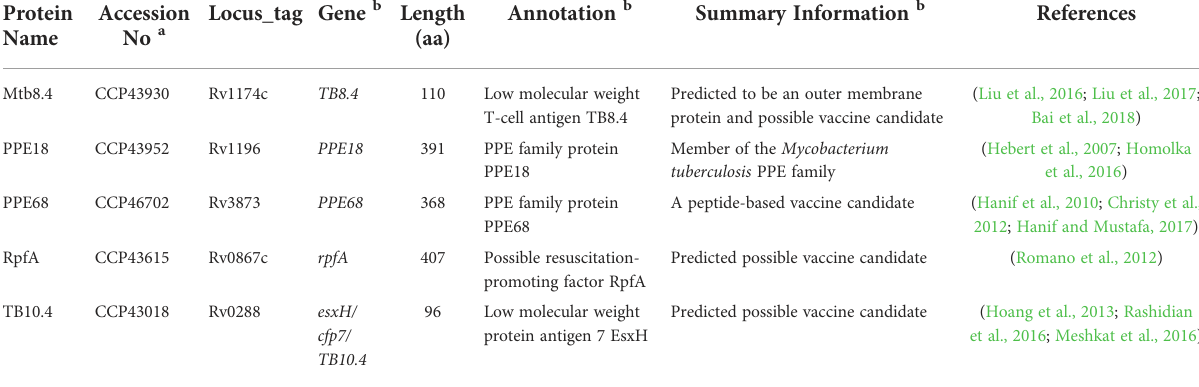
TABLE 1 Summary of basic information about the fi ve antigens that make up the MP3RT vaccine (Gong et al., 2021a).